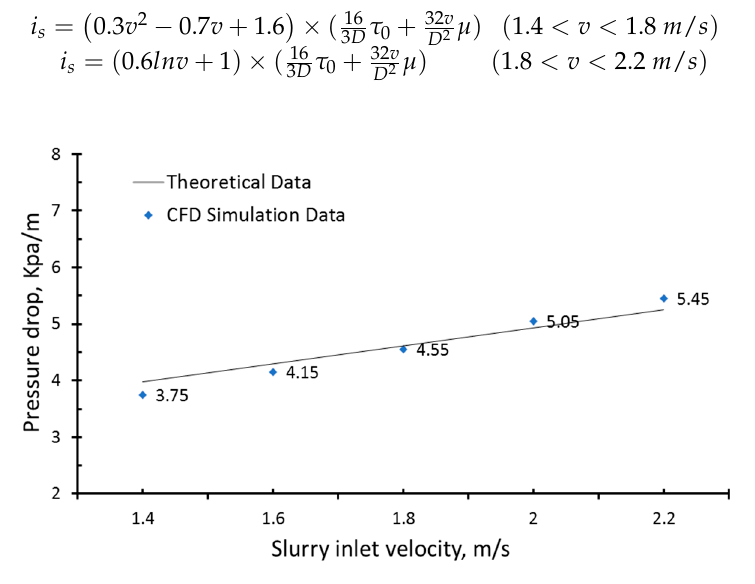
Figure 10. Comparison of the simulation data and theoretical data for the resistant loss in the pipe